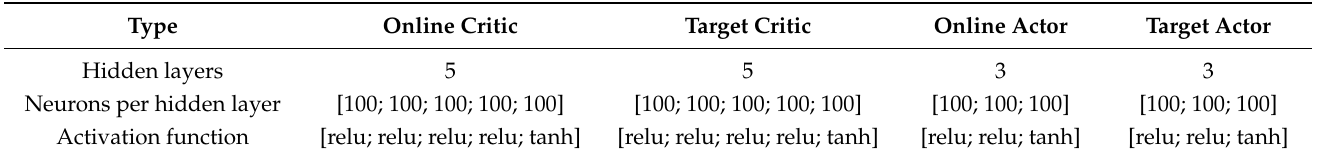
Table 4. The specific parameters of the neural networks in